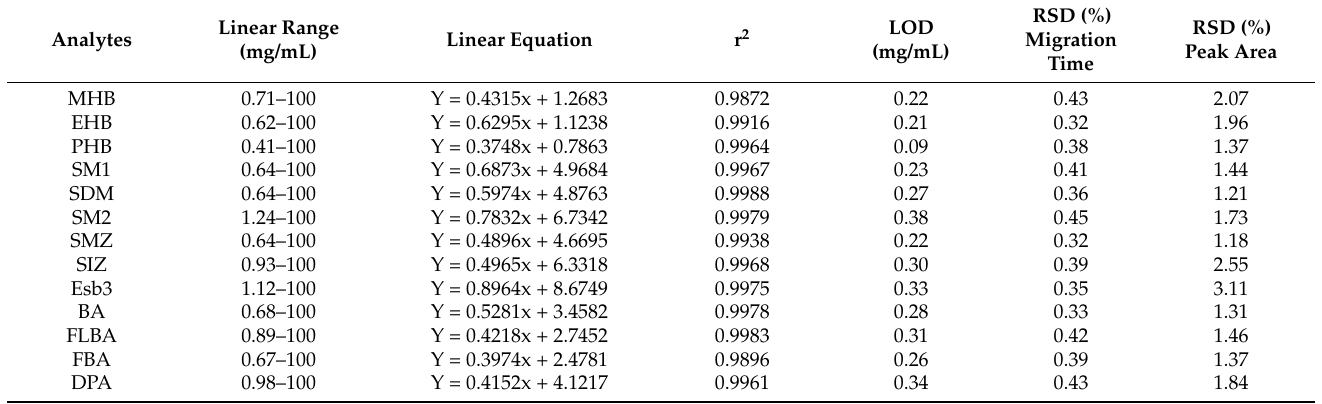
Table 4. Linear ranges, linear equation, LODs and the RSDs for the small molecular compounds.